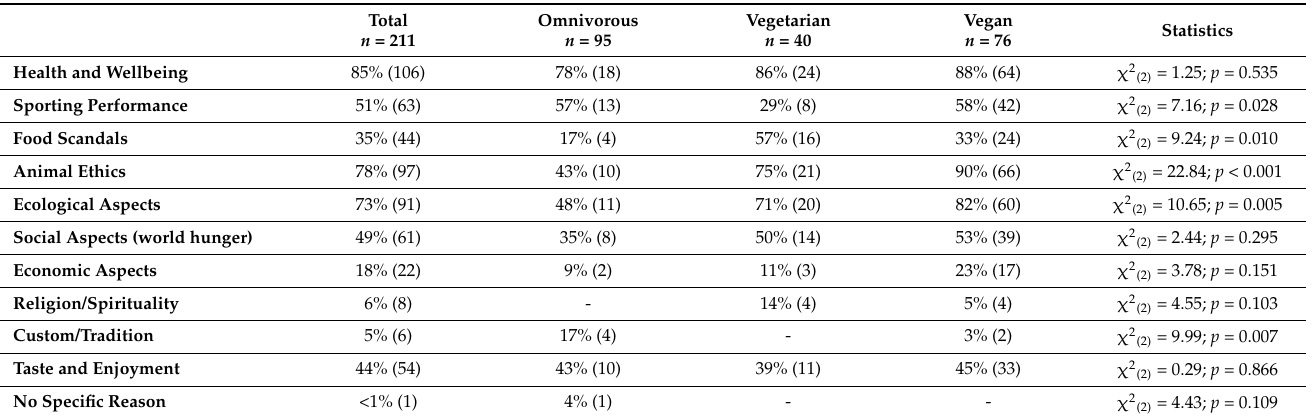
Table 3. Motives of runners for adhering to their self-reported diet types and differences between dietary subgroups.